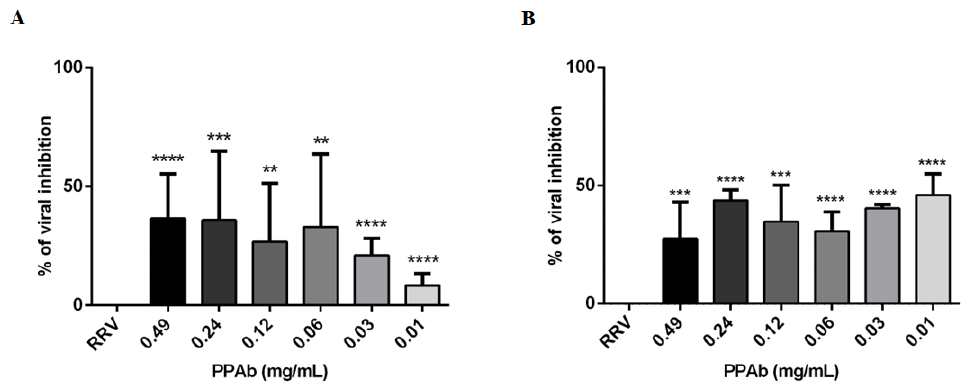
Figure 4. Anti-rotavirus activity of the PPAb analyzed by flow cytometry. ( A ) Virucidal effect: Different concentrations of PPAb were incubated with infectious RRV (RRV) particles at 37 ◦ C for 2 hrs. PPAb-RV mixtures were added to MA104 cells (final MOI = 0.1) for at 37 ◦ C and 5% CO 2 for 1 h. Then, the inocula were removed and replaced by fresh culture medium without FBS and incubated for 9 h. ( B ) Post- infection anti-rotavirus activity: MA104 cells were incubated with RRV (MOI = 0.1) for 1 h to facilitate viral adsorption. The viral inocula were then removed and replaced with culture medium without FBS and different concentrations of the PPAb. Cells were incubated at 37 ◦ C and 5% CO 2 for 9 h to verify viral replication. For both assays cells were detached with trypsin-EDTA, stained for cytoplasmic RV proteins using rabbit polyclonal anti-TLP antibodies (primary antibody) and a goat anti-rabbit IgG (H + L) antibody conjugated with Alexa Fluor 488 (secondary antibody), and acquired on a flow cytometer; 10,000 events were analyzed for each condition. MOCK: Non-RRV infected cells; RRV: RRV-infected cells. Experiments were done in duplicates and repeated independently four times. Bars represent mean ± SD. ** p < 0.01, *** p <0.001, **** p < 0.0001; Mann-Whitney test for comparisons with the control of RRV-infected